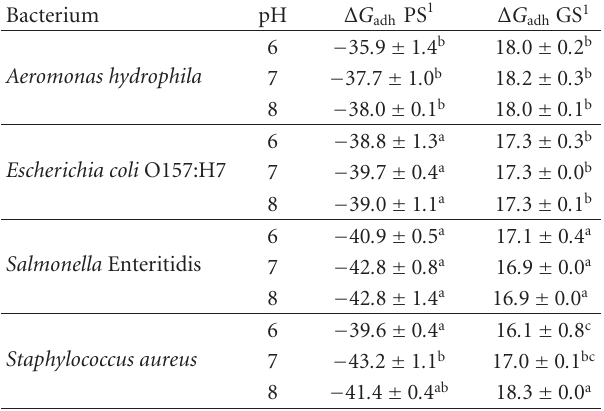
Table 2: Free energy of adhesion (mJ · m − 2 ) of the four pathogens to polystyrene (PS) and to glass (GS) as a function of culture pH.